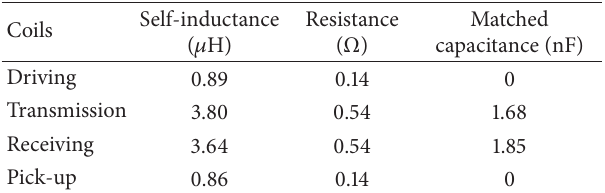
Table 1: Coil parameters.